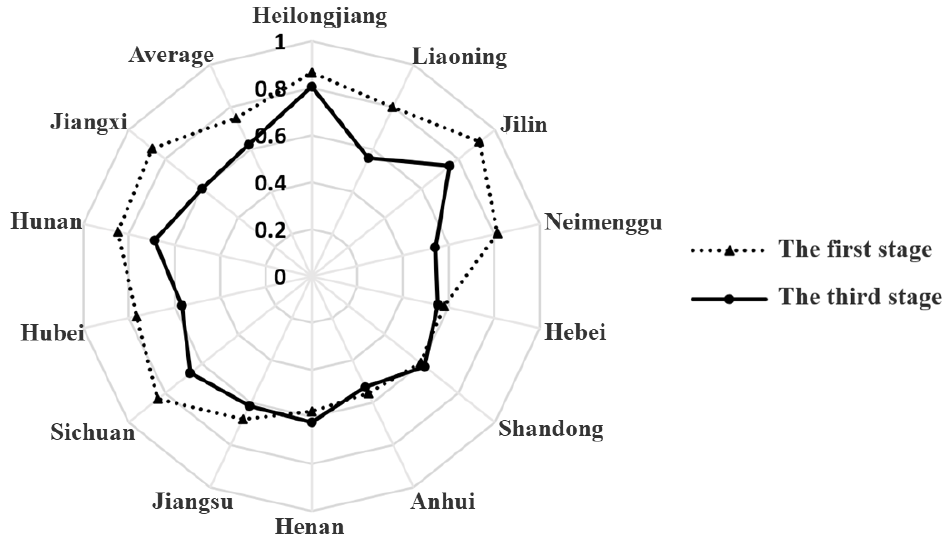
Figure 5. Comparison of averages of comprehensive technical efficiency of grain production resource allocation in different regions before and after adjustment.